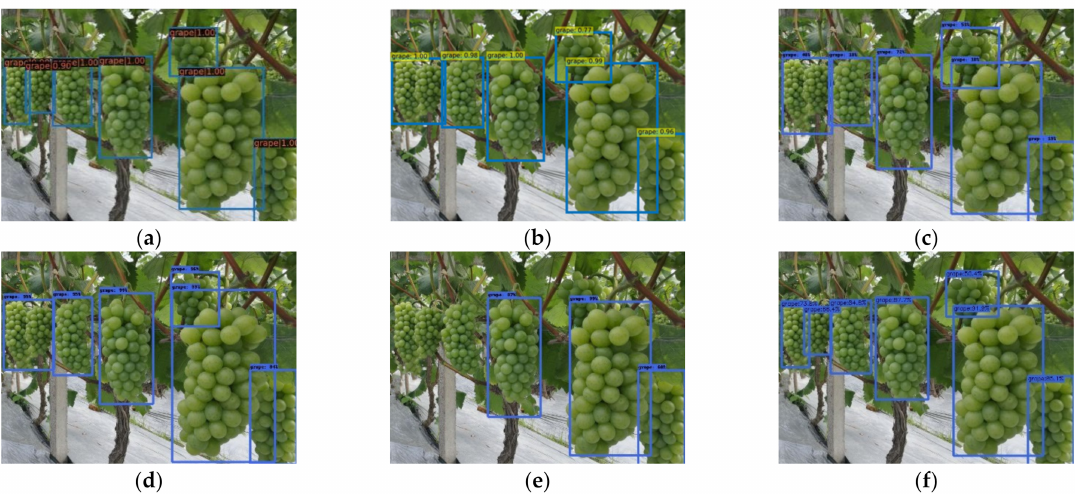
Figure 11. Bunches of green grapes detection in case 2: ( a ) SwinGD, ( b ) DETR, ( c ) YOLOv3-SPP, ( d ) Faster-RCNN, ( e ) SSD, ( f ) YOLOX.